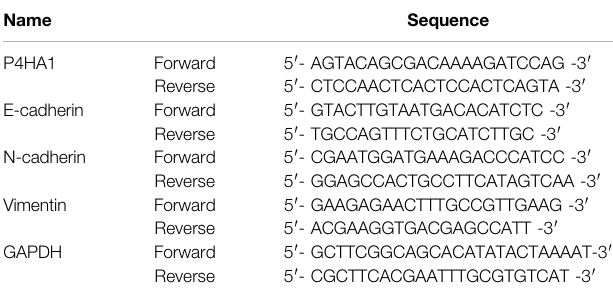
TABLE 1 | Sequences of primers for